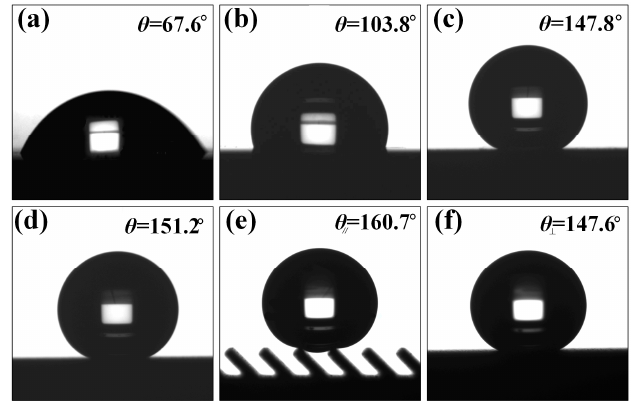
Figure 4. The contact angle of water with different scale structures on the surface: ( a ) smooth surface, ( b ) smooth surface after modification, ( c ) WEDM processed surface without groove structure, ( d ) WEDM-AH reacted surface without groove structure after modification, ( e ) WEDM-AH reacted inclined groove surface in the parallel direction, and ( f ) WEDM-AH reacted inclined groove surface in the perpendicular direction.